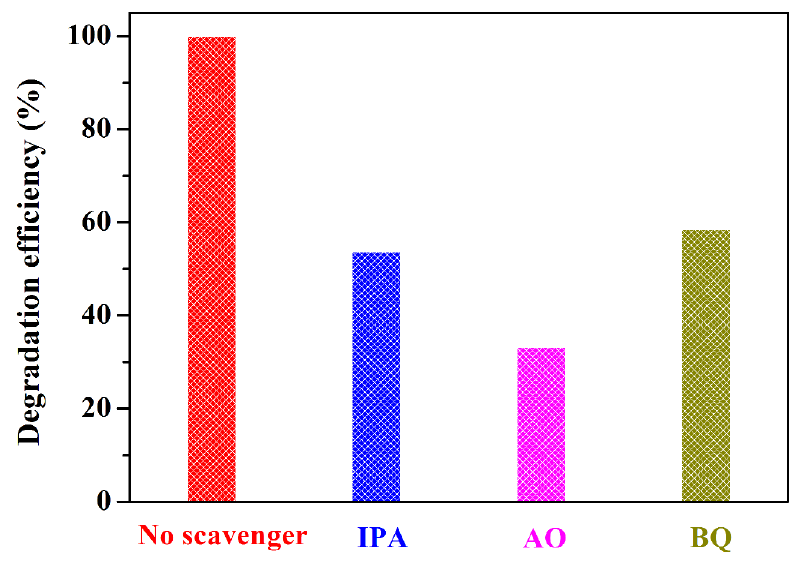
Figure 8. Influences of different quenchers on the photocatalytic capability of Ag/AgCl/BiOCH-3.